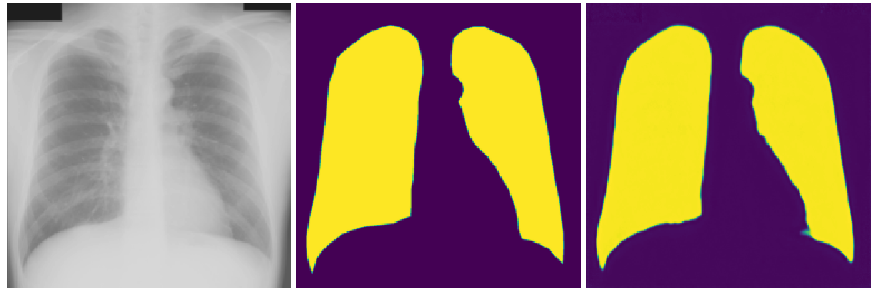
Figure 3. Best segmentation dice score (0.941) visualization, ( left ): original image, ( middle ): ground truth, ( right ): predicted segmentation.